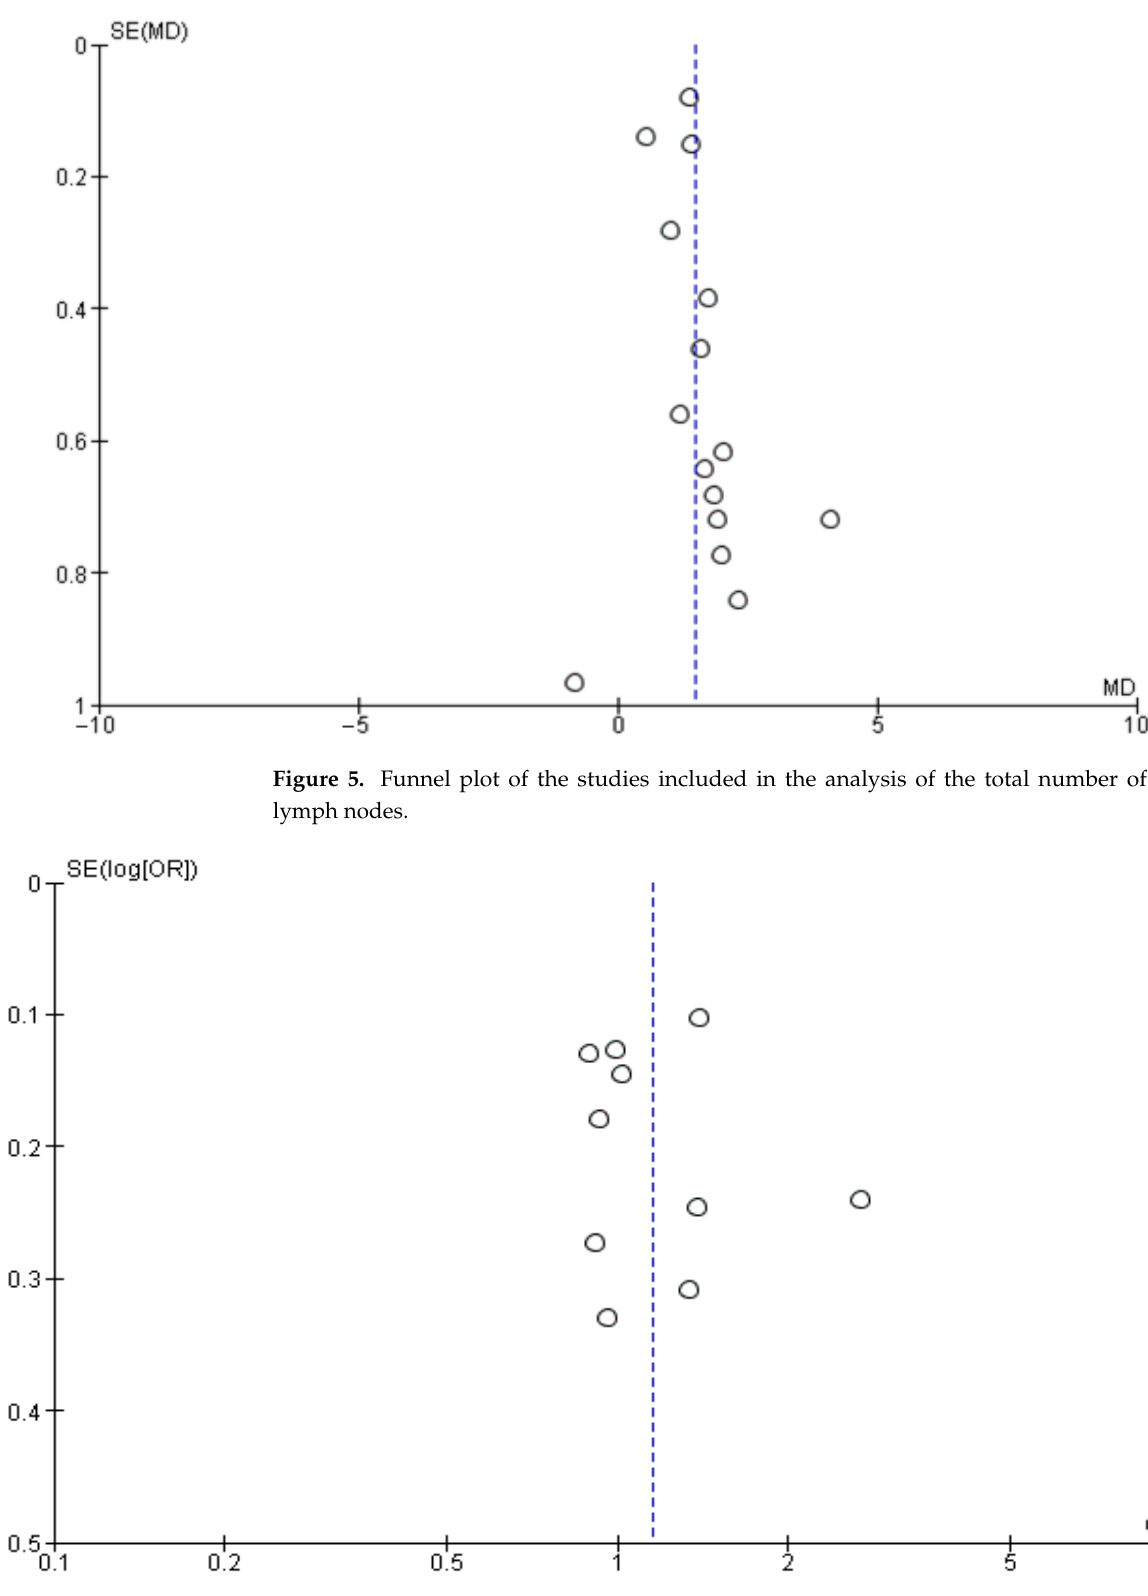
Figure 6. Funnel plot of the studies included in the analysis of the metastatic lymph nodes harvested.